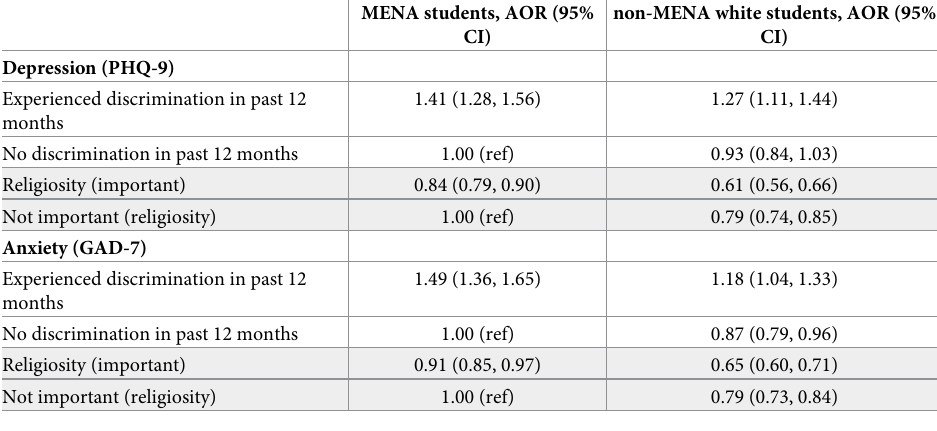
Table 3. Results of adjusted logistic regression models incorporating an interaction term to examine the modify- ing roles of religion and discrimination on Arab ethnicity and mental health outcomes (depression and anxiety). Models were adjusted for age ( < = 21/22+), gender (male/female/other), sexual orientation (hetero/gay/other), first generation (yes/no), citizen